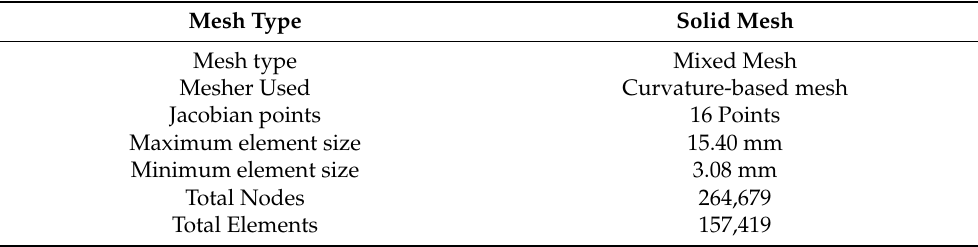
Table 4. Mesh information for FEM (finite element method) analysis.